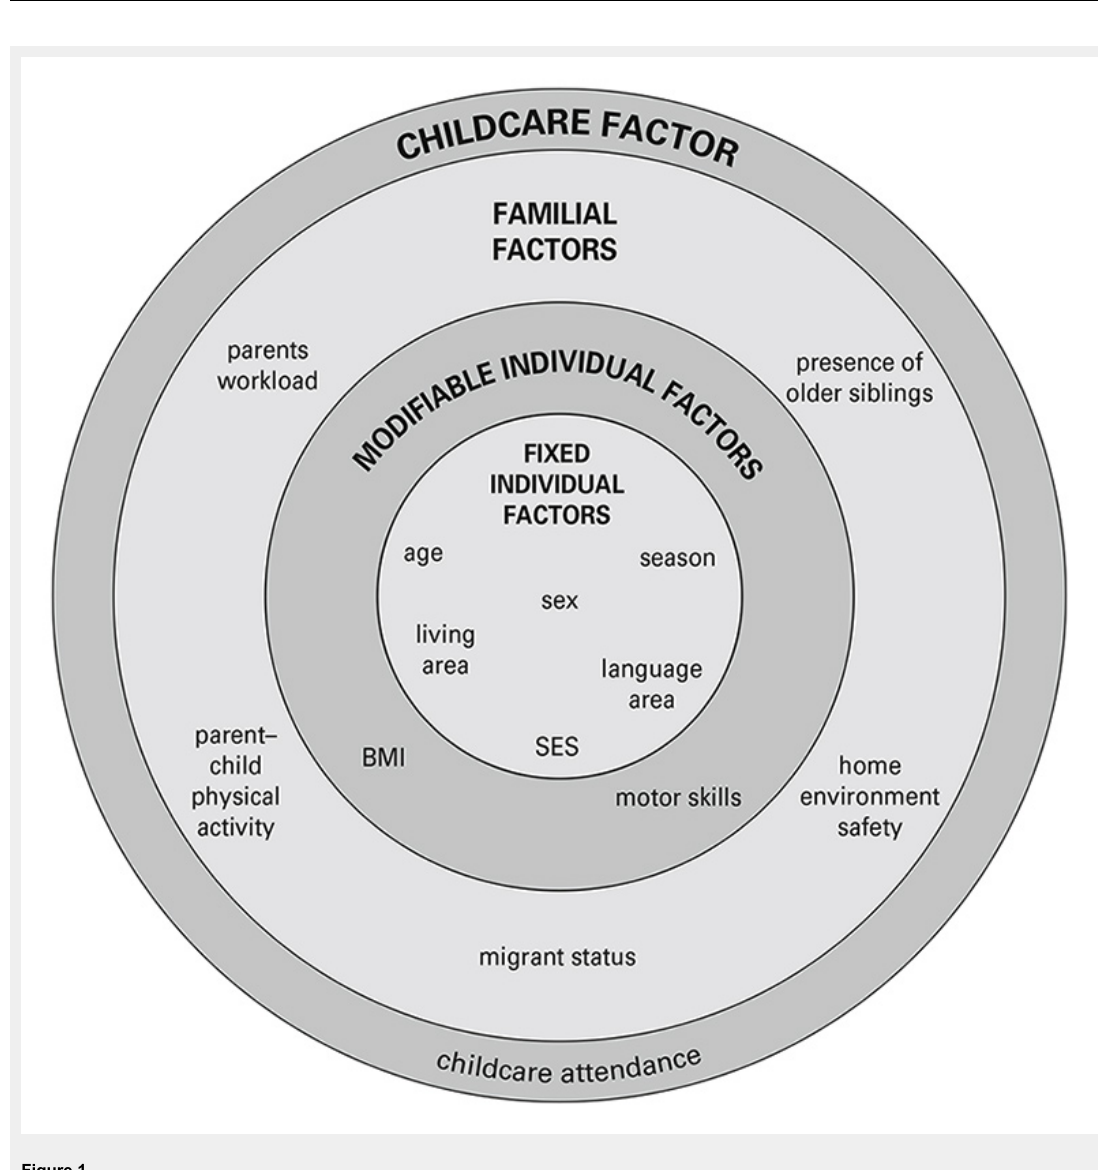
Figure 1 Based on the socioecological model potential correlates of physical activity and sedentary behaviour were grouped in different sets and added stepwise in the analysis. Model 1 included the core correlates with fixed individual factors, Model 2 = Model 1 + modifiable individual factors, Model 3 = Model 2 + familial factors, Model 4 = Model 3 + childcare factor. BMI = body mass index; SES = socioeconomic